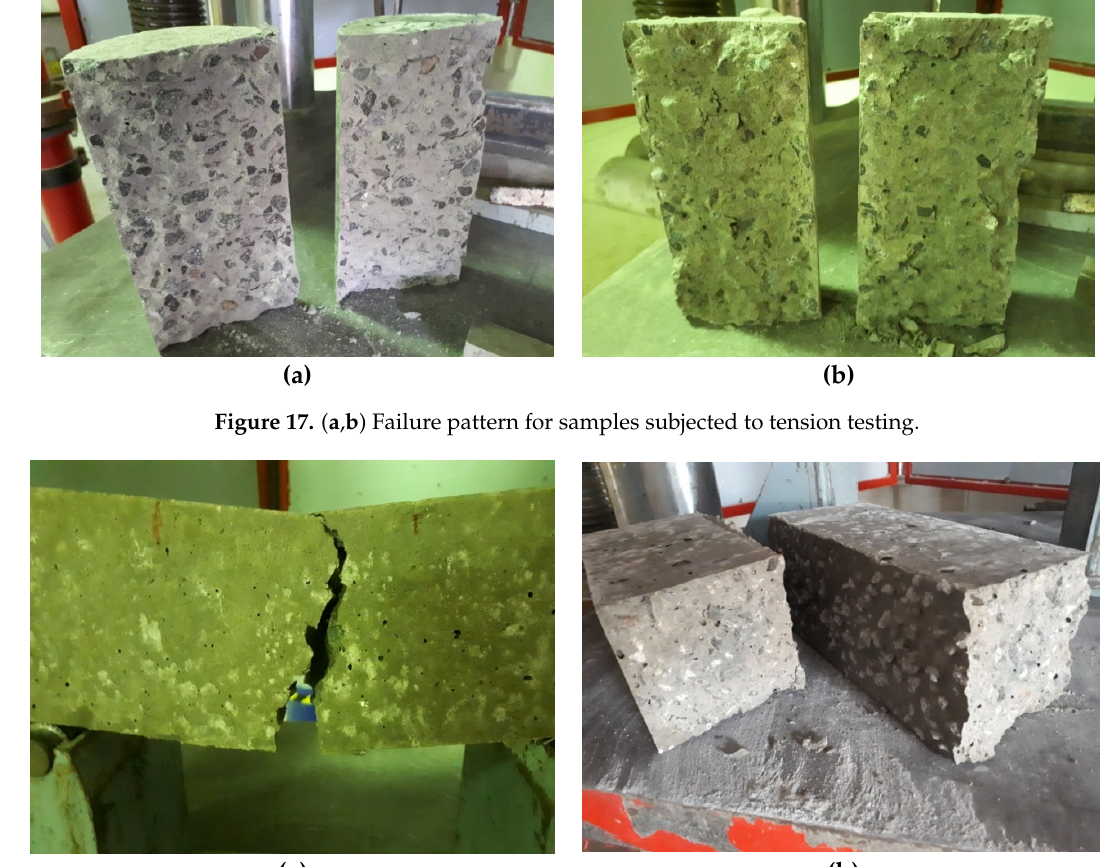
Figure 18. (a,b) Failure pattern for samples subjected to flexural testing. Figure 18. ( a , b ) Failure pattern for samples subjected to flexural